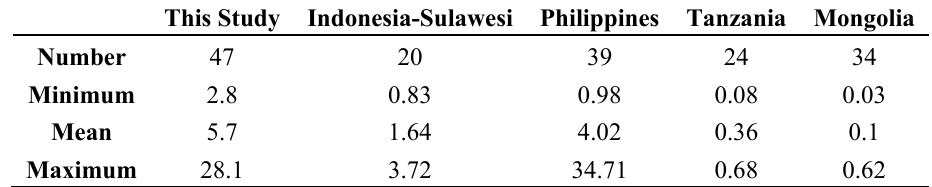
Table 2. Hair mercury concentrations ( μ g/g) of inhabitants from control areas of this study compared to other publications [40].